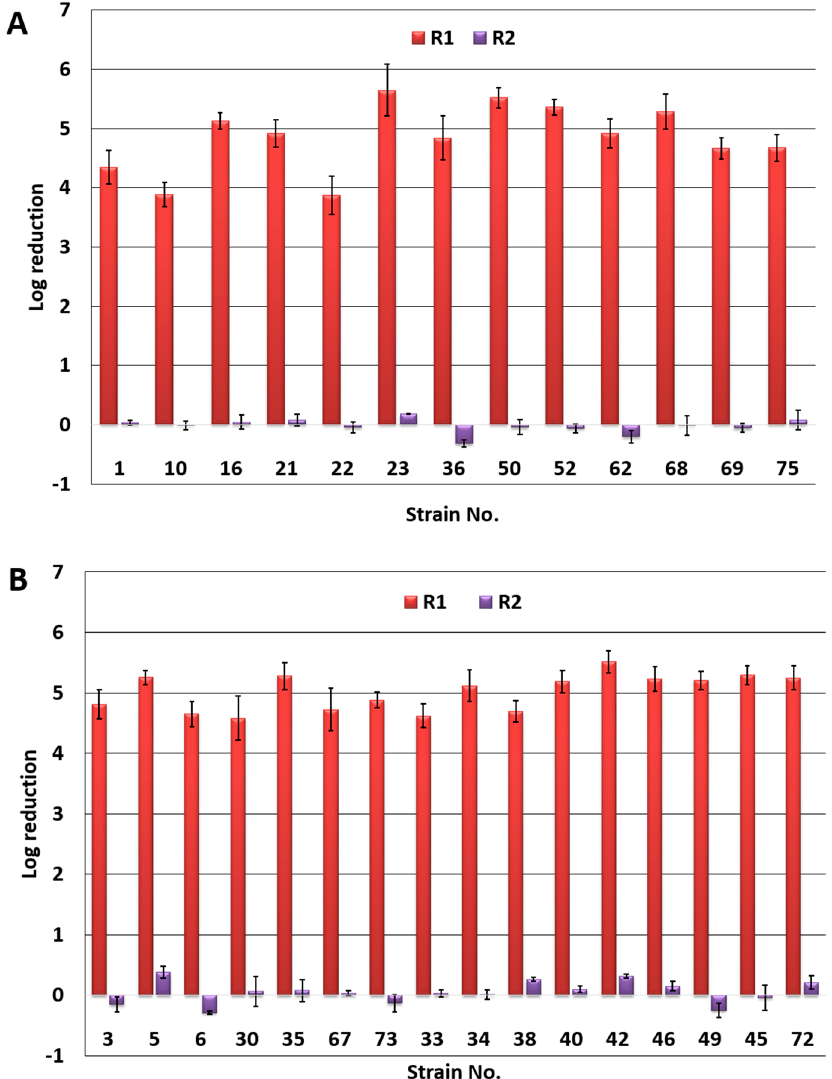
Figure 3. Values of reduction factors (R1 and R2) based on clinical strains of P. aeruginosa treated with Pc+ at a concentration of 1.0 × 10 − 4 M in the dark (dark toxicity) and after irradiation with light (photocytotoxicity): ( A ) photocytotoxicity and toxicity—strains isolated from lower respiratory tract; ( B ) photocytotoxicity and toxicity—strains isolated from chronic wounds. Abbreviations: R1—photodynamic inactivation; R2—dark toxicity; R1 = Log L(-)Ps(-)—Log L(+)Ps(+); R2 = Log L(-)Ps(-)—Log L(-)Ps(+); L(-)Ps(-)—no irradiation, no Pc+ (negative control); L(-)Ps(+)—no irradiation, Pc+ (dark control); L(+)Ps(+)—irradiation, Pc+.